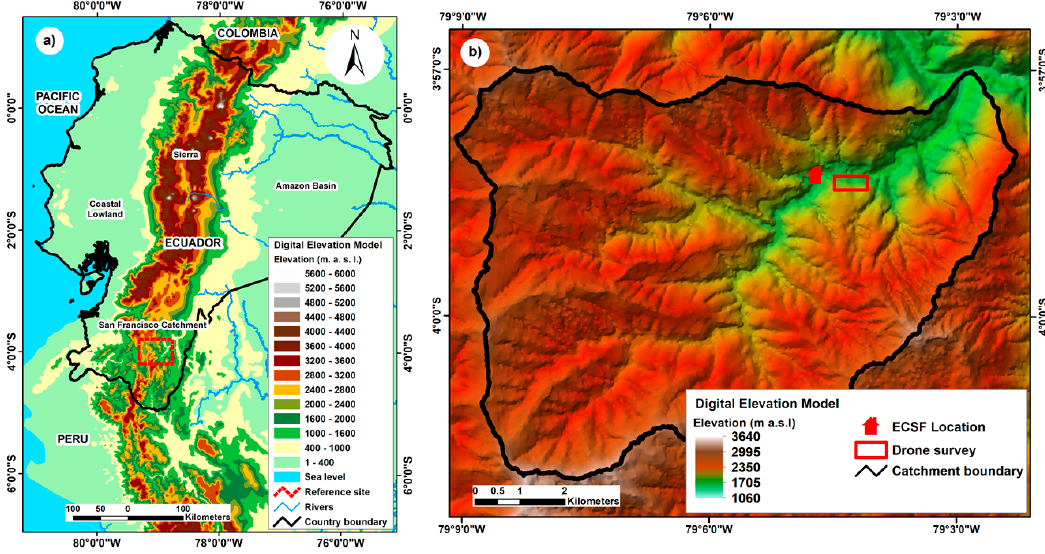
Figure 1. ( a ) Digital elevation model (DEM) of Ecuador, and ( b ) DEM of the San Francisco catchment including the study area.